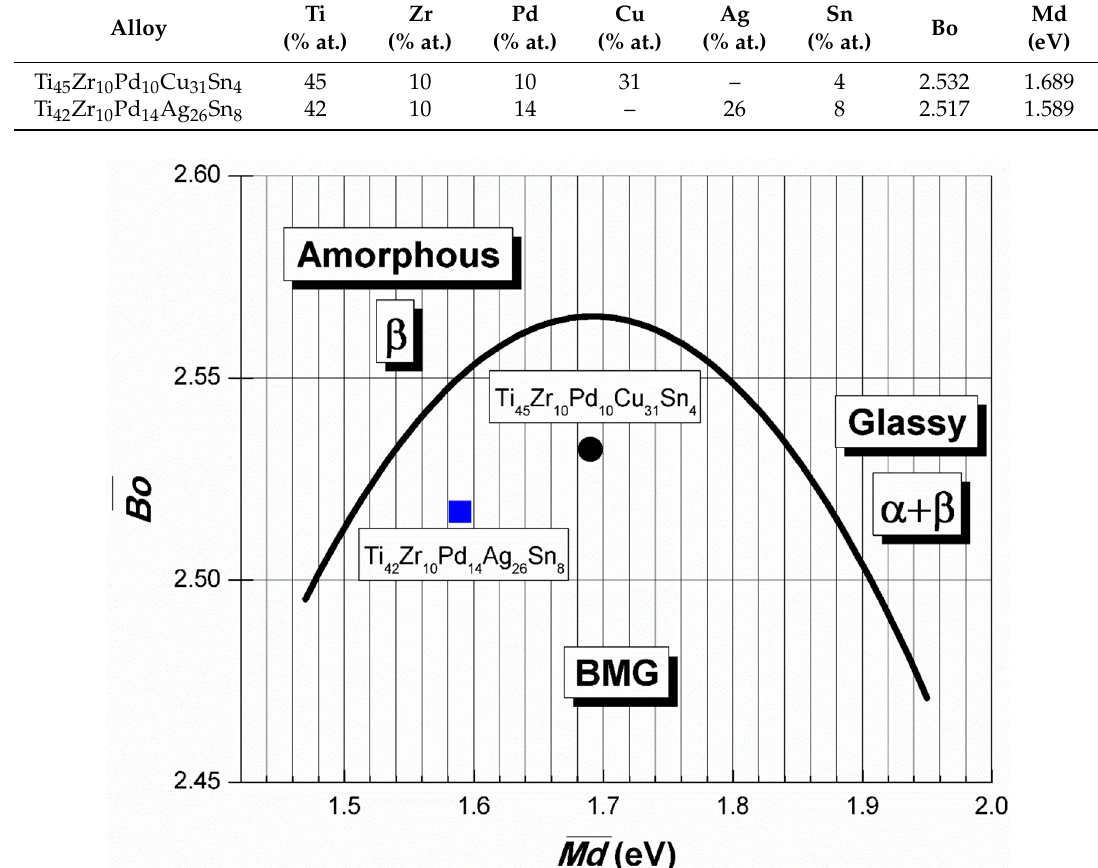
Figure A1. Positions of Ti 45 Zr 10 Pd 10 Cu 31 Sn 4 and Ti 42 Zr 10 Pd 14 Ag 26 Sn 8 alloys on the distribution chart of amorphous and glassy alloys, based on B o and M d parameters (adapted from reference [33]).